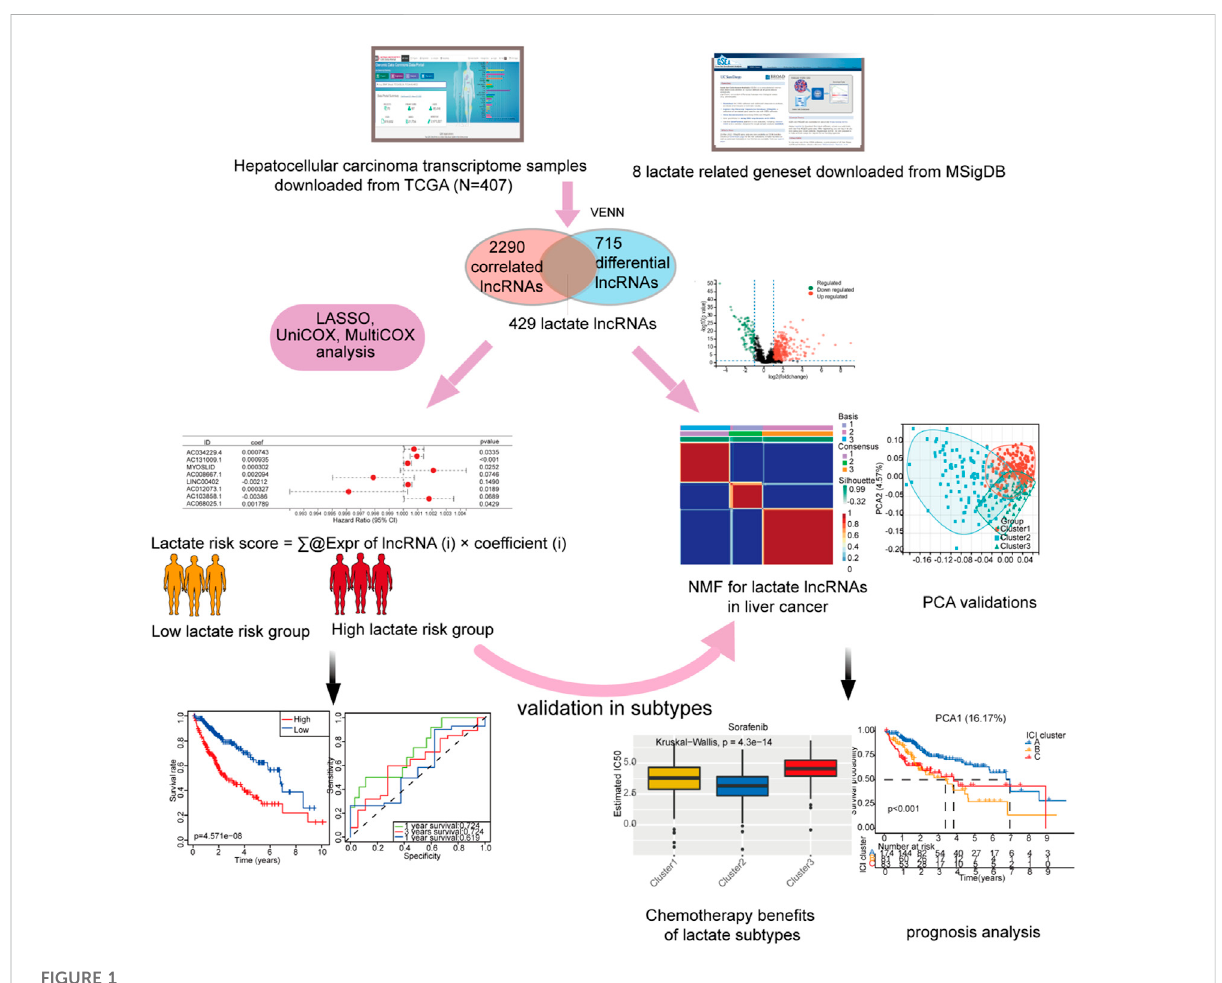
FIGURE 1 Overall fl owchart of this